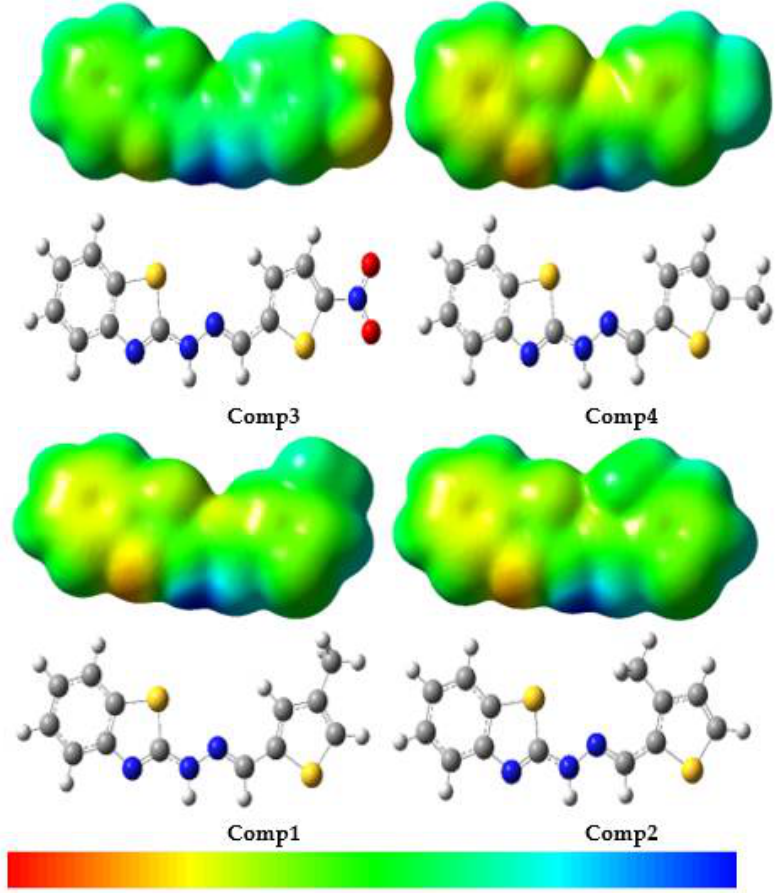
Figure 7. Molecular electrostatic potential surfaces views of benzothiazole derivatives.